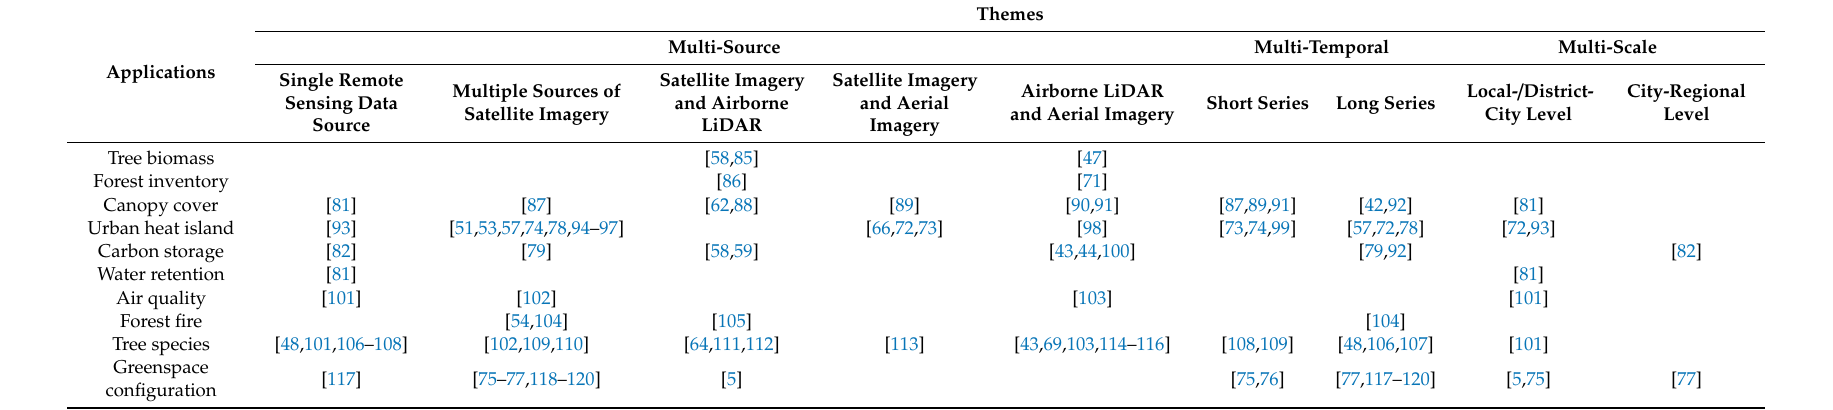
Table 1. Classified studies in terms of applications and